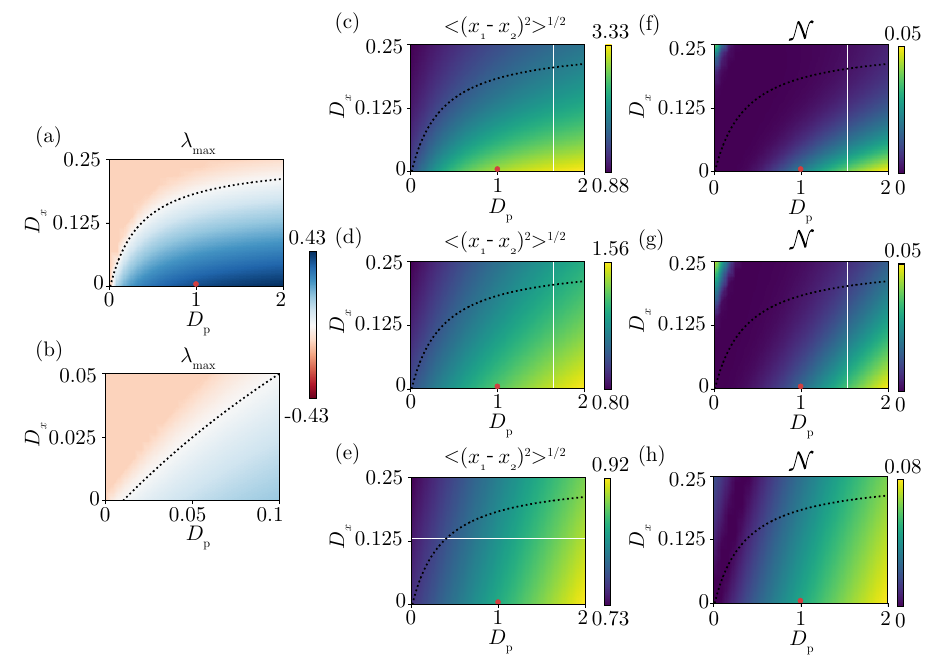
Figure 6. Dependence of the eigenvalue, nonuniformity, and negativity on the diffusion constants D x and D p . ( a , b ) Maximum eigenvalues (cid:31) max . ( b ) shows a blowup of ( a ) near the origin. ( c , d , e ) Root mean squared ( x 1 x 2 ) 2 distance . ( f , g , h ) Negativity N . In each figure, the critical curve of the Turing instability in the � − � 0 ) is represented by a black-dotted curve and the red dot represents the classical limit (i.e., on which (cid:31) max (cid:31) = ( 0.005, 0.995 ) used in Figs. 3, 4, and 5. The parameters are � diffusivities ( D x , D p ) = 2 γ 2 γ 1 0.1 , where γ 1 0.4, γ 2 0.1 in the semiclassical regime ( c , f ), γ 1 and − 2 = − = = 6.2, γ 2 3 in the strong quantum regime ( e , h quantum regime ( d , g ), γ 1 = =